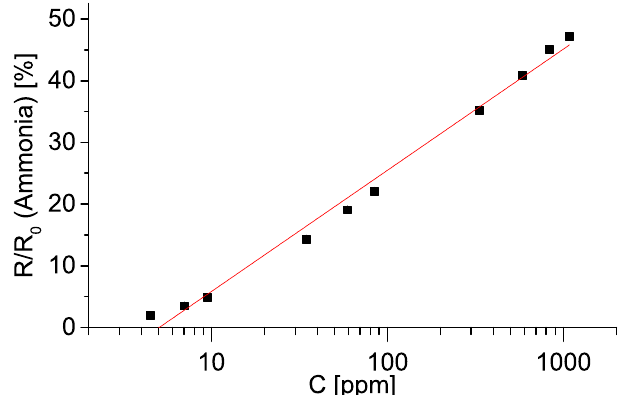
Figure 8. Dependence of electrical resistance of an oxidized sample on ammonia gas concentration (in ppm). Error bars showing five standard deviations are smaller than the size of the points. For details see Section